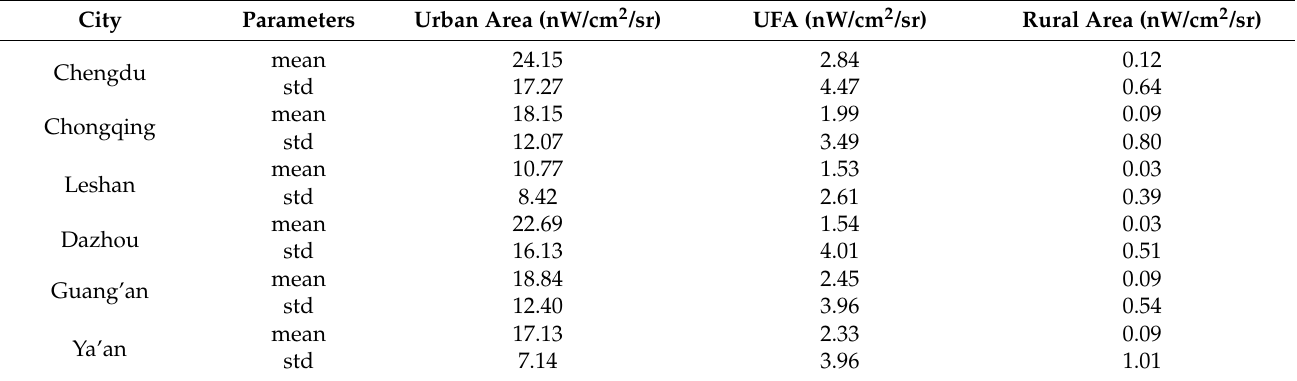
Table 5. Verification results of NPP-VIIRS-like NTL.